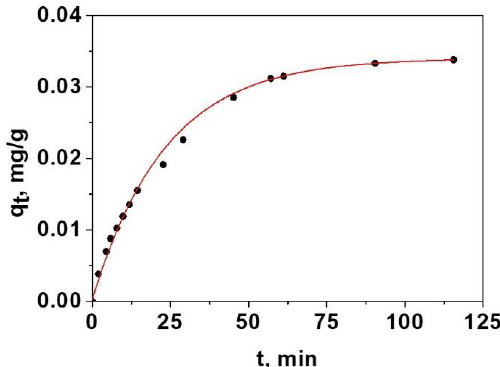
Figure 2. Non-linear fitting of the data of adsorption of glycine in the sensory film using the Crank model of dual resistance Equations (3)–(5).